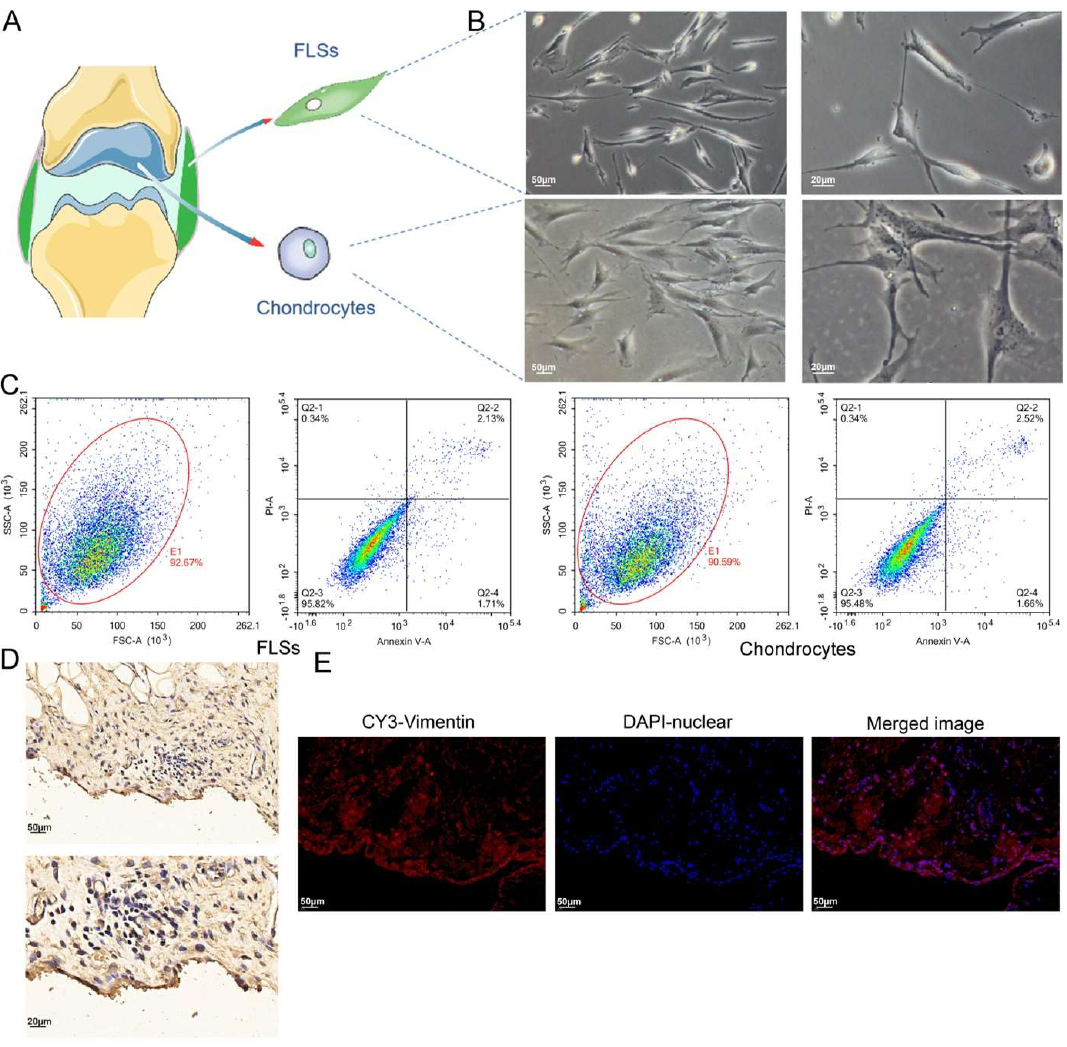
Figure 4. Labeling of FLSs in SM, and cell viability detection for isolated FLSs and chondrocytes. ( A ) FLSs and chondrocytes obtained from SM and AC of rats, respectively. ( B ) Observation of FLSs and chondrocytes using light microscopy. ( C ) FCM was used to determine the viability of FLSs and chondrocytes. ( D ) Vimentin IHC staining of SM. ( E ) Vimentin IF staining of SM. FCM was used to determine the viability of the FLSs and the isolated